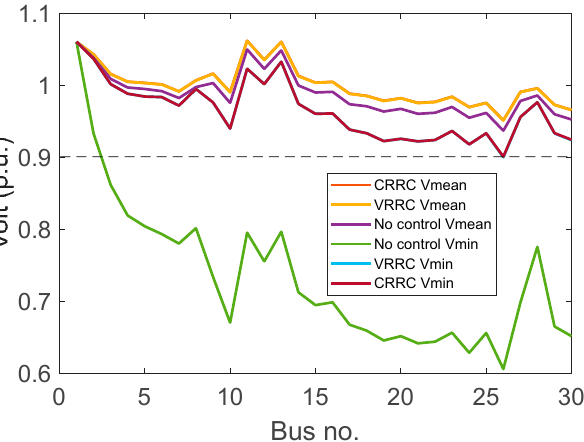
Figure 11. The minimum voltage profiles and the 24 h mean voltage profiles for each scenario under 5% increment in electrical system